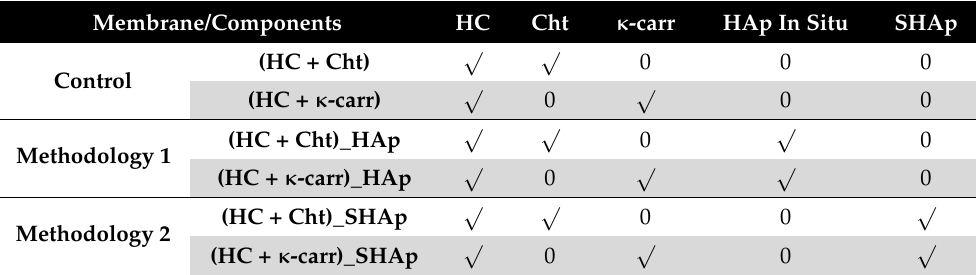
Table 1. Codes for the hybrid membranes prepared by using hydrolyzed collagen (HC) and chitosan (Cht) or kappa-carrageenan ( κ -carr) and hydroxyapatite (HAp) precipitation in situ (Methodology 1) or ex situ (Methodology